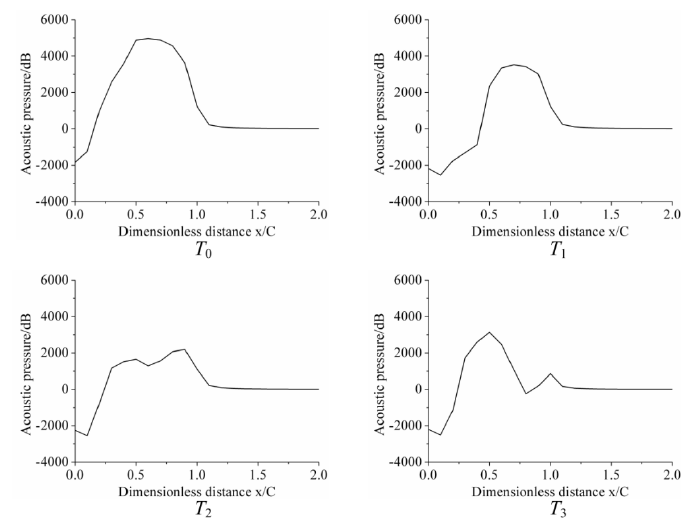
Figure 11. Acoustic pressure at different flow times for σ = 0.975.